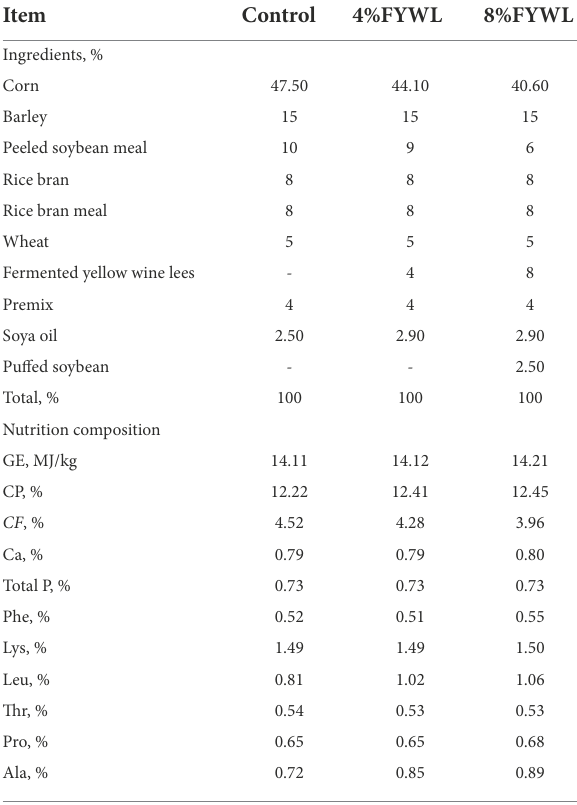
TABLE 2 The composition and nutritional content of the